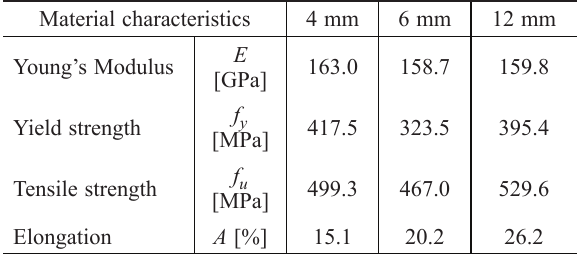
Table 1. Average values of material